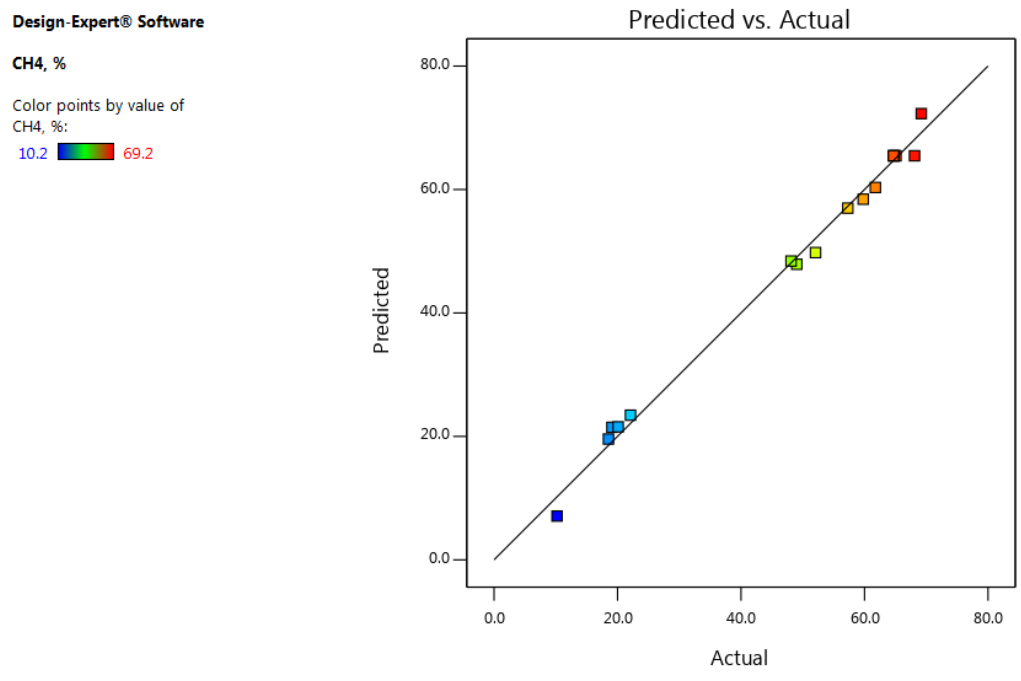
Figure 6. Scatter plot of the predicted values versus the actual values of the CH 4 % response.